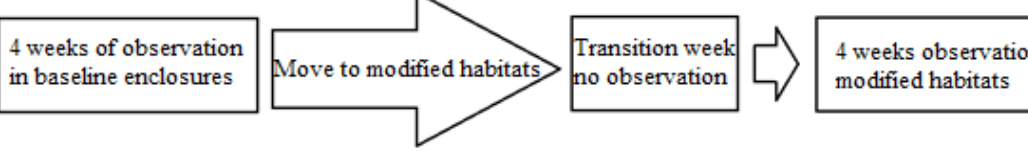
Figure 2 . Timeline for behavioral observations.